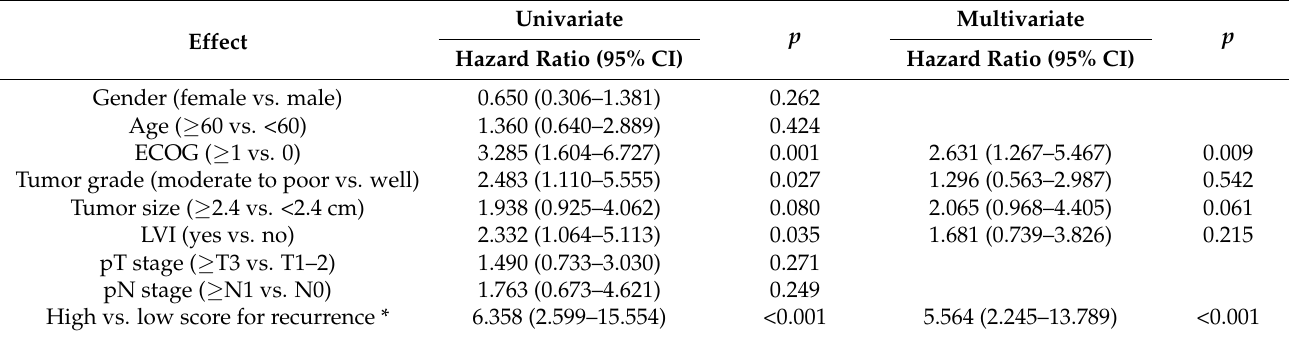
Table 5. Risk factors for the 3-year recurrence of patients with surgically resected lung adenocarcinoma in the external validation sets ( n =